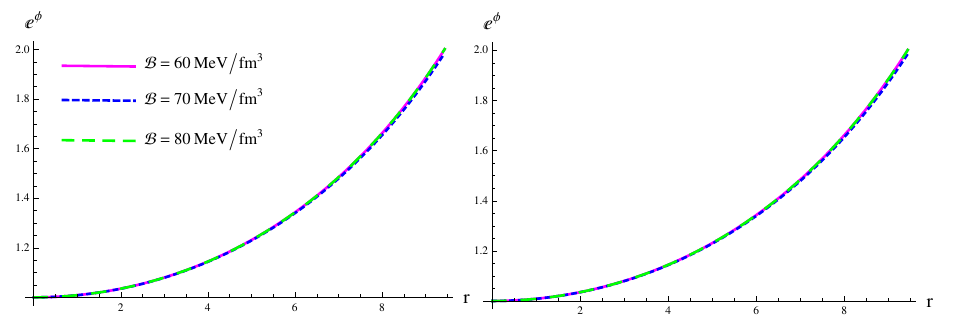
Figure 1. Plots of deformed radial metric components of solution I for Υ = 0.2 ( left ) and Υ = 0.9 ( right ).